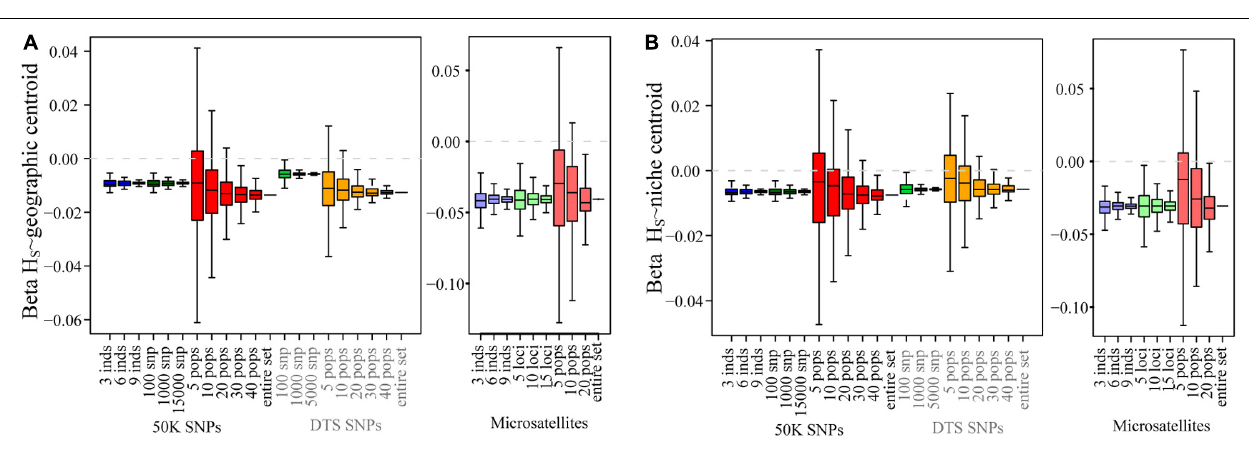
FIGURE 3 | The effect of sampling designs on the estimation of the central abundance hypothesis for genomic and microsatellite datasets: (A) the association between distance to the geographic centroid and H s; (B) the association between distance to the niche centroid and H s. Boxplots show the distribution of associations estimated for 1,000 simulations varying the number of individuals, number of SNPs, and number of sampled populations. The dotted gray line shows the 0